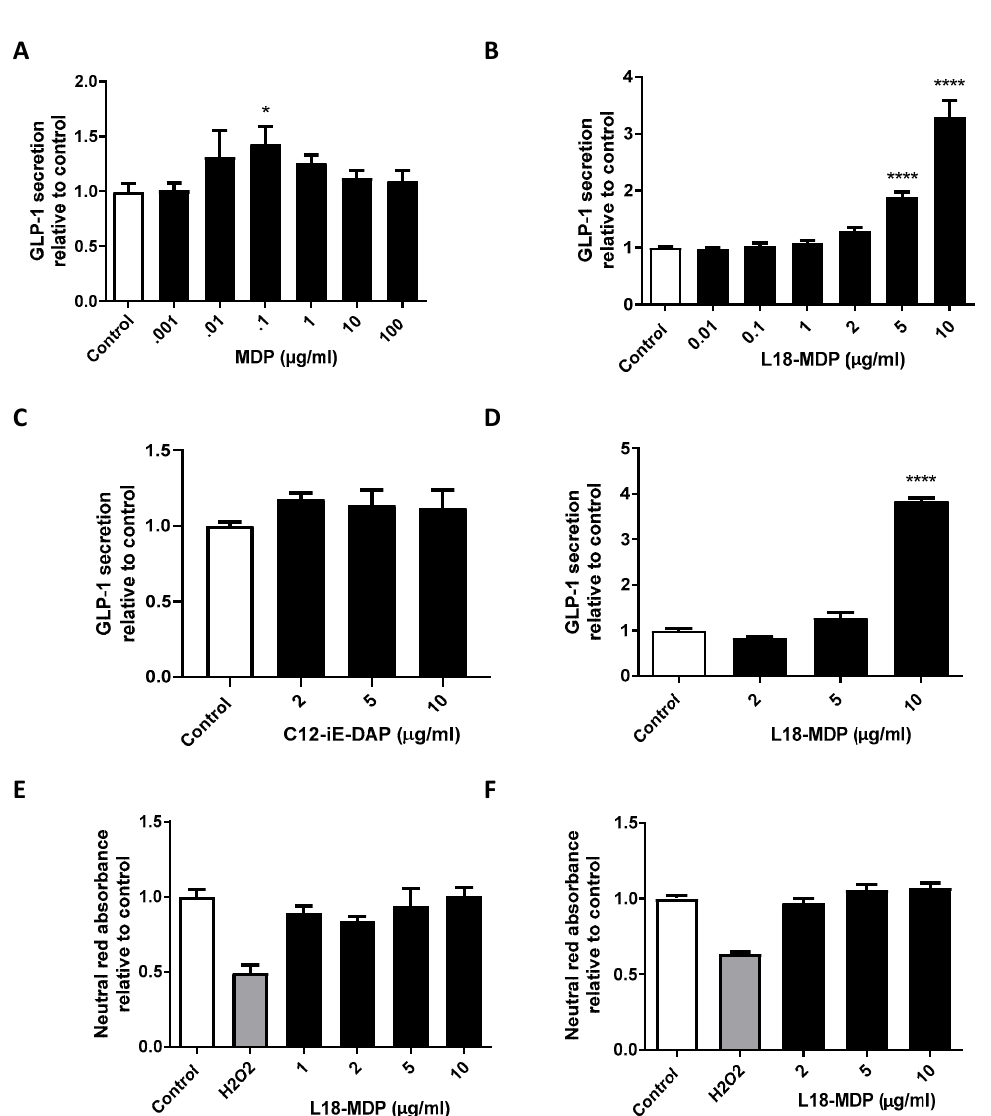
Figure 1. Fatty-acid modified muramyl dipeptide (L18-MDP) stimulates glucagon-like peptide-1 (GLP-1) secretion from L-cells. Percent active GLP-1 secretion relative to control was examined in GLUTag cells after 2 h treatments with MDP, n = 3–9 ( A ), L18-MDP, n = 3–18 ( B ), and fatty-acid modified γ - d -Glu-mDAP (C12-iE-DAP), n = 6 ( C ). Percent active GLP-1 secretion relative to control was examined in NCI-H716 cells after 2 h treatments with L18-MDP, n = 4 ( D ). Cell viability was measured by neutral red absorbance in GLUTag ( E ) and NCI-H716 ( F ) cells, n = 4. Results analyzed by one-way ANOVA and Dunnett’s post-hoc test. * p < 0.05, **** p < 0.0001 versus control cells. Values shown as mean ± SEM.